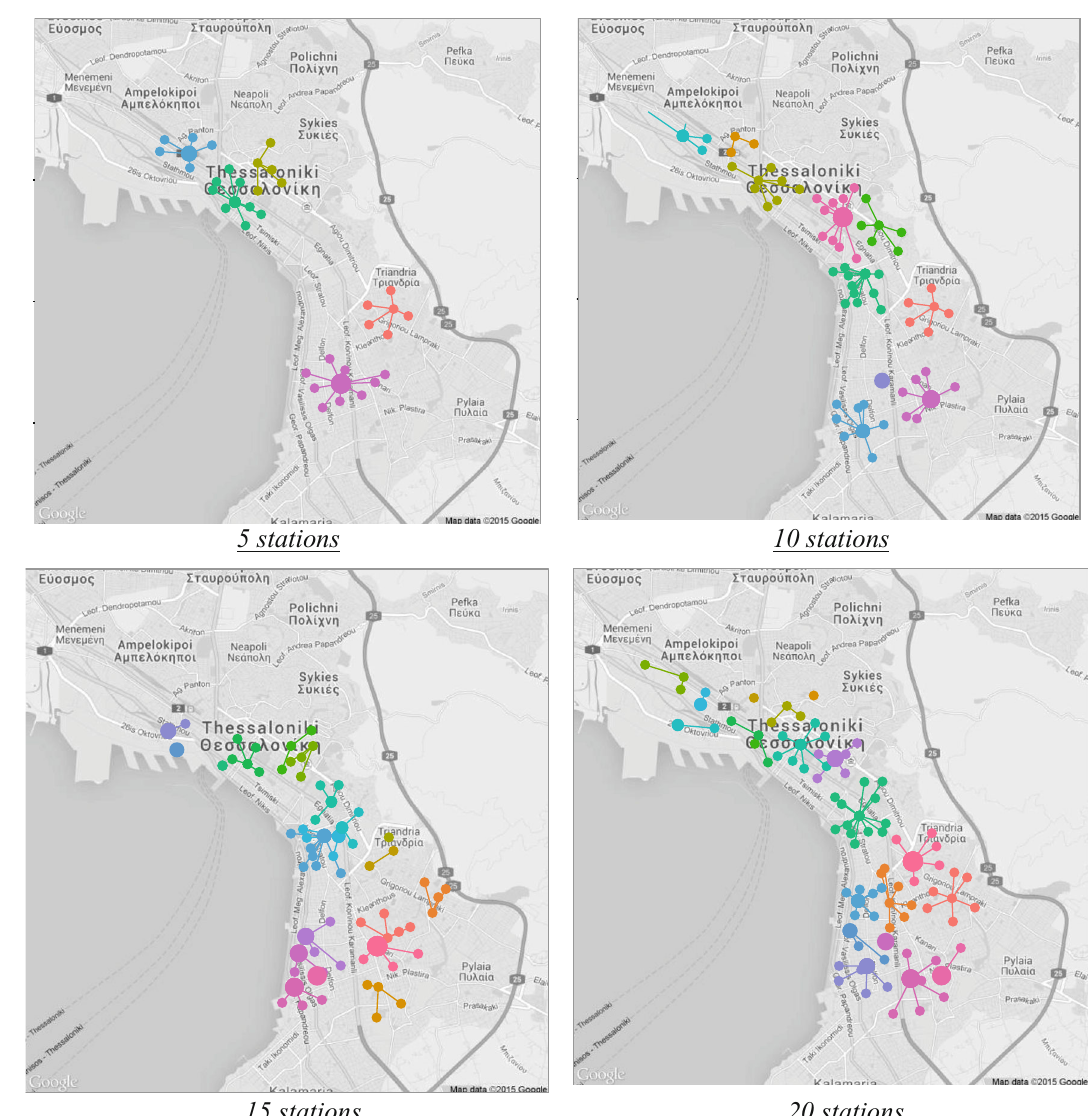
Fig. 5 GA result - Optimal locations. Points (zone centroids) of same color are served by the same